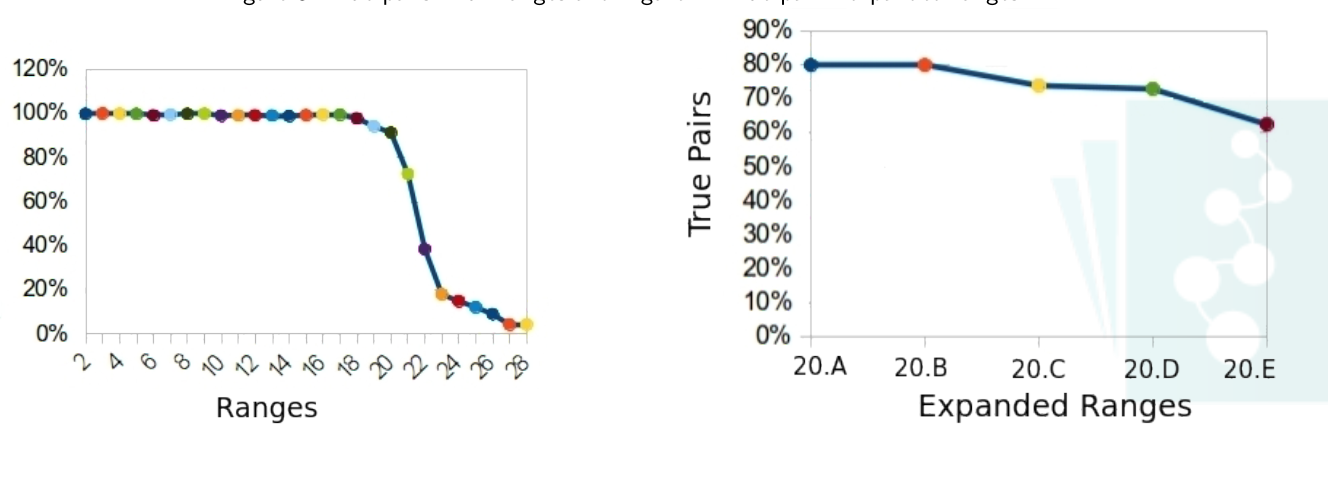
Figure 3: True pairs x full ranges and Figure 4: True pair x expanded